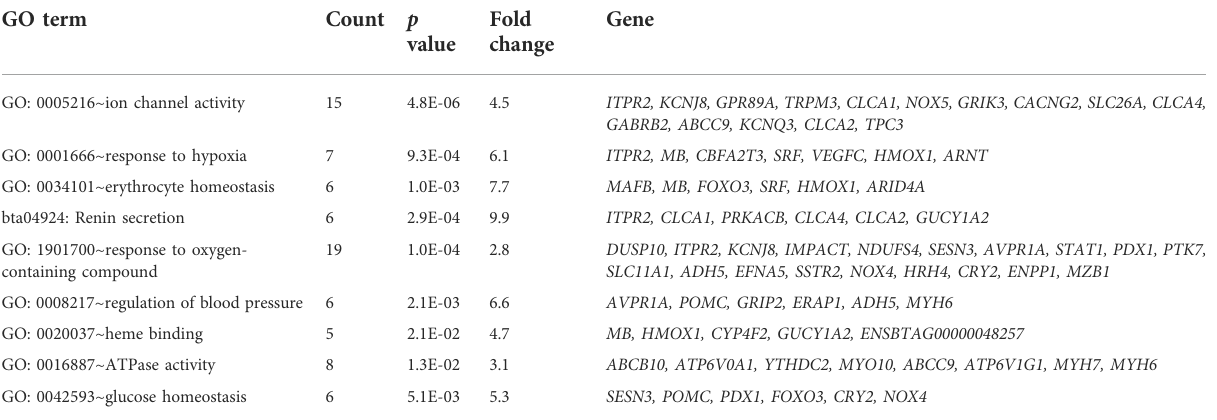
TABLE 3 Gene ontology (GO) clustering and enrichment analyses of candidate genes identi fi ed by genome-wide iHS and XP-CLR scans in the high- altitude cattle populations. GO